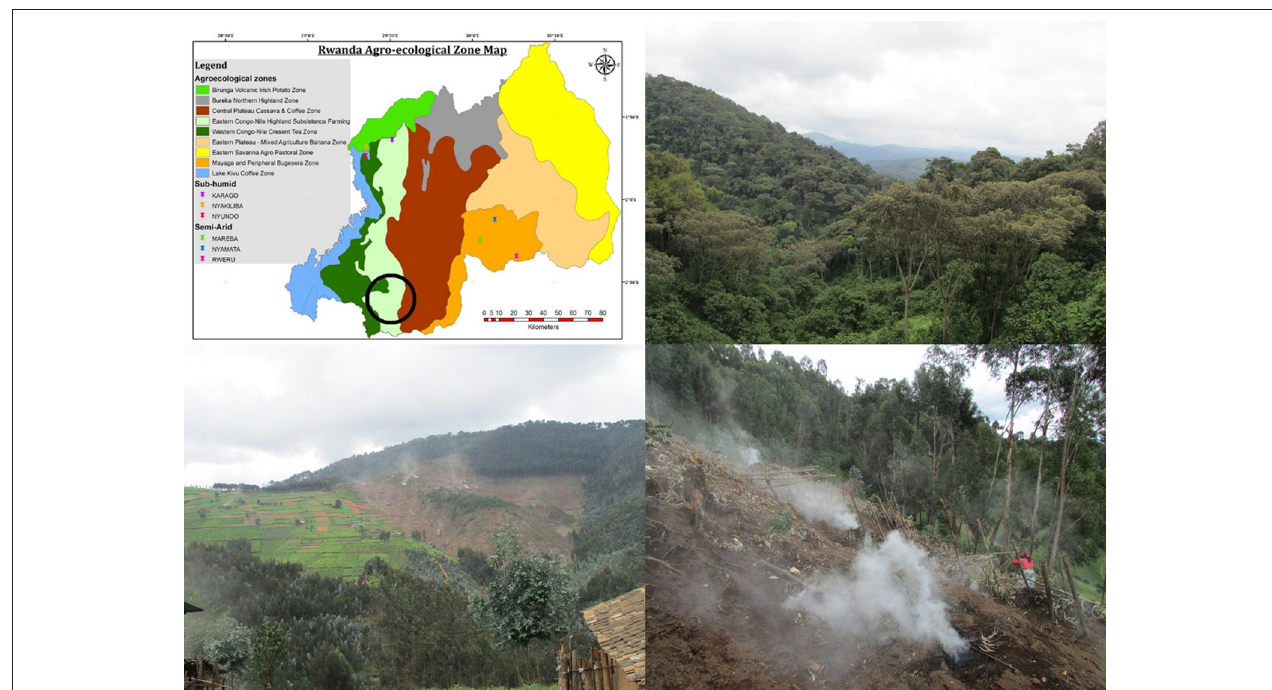
FIGURE 3 | Rwandese site illustration. Nyungwe Forest is the largest block of montane forest in East and Central Africa, home to over 1,000 species, including rare primates, such as chimpanzees, the L’Hoests monkey and Angola Colobus. Nyungwe is also an important water catchment for Rwanda. Western Rwanda is one of the most densely populated regions of the country and at the same time one of the major suppliers of charcoal made from planted Eucalyptus. By ameliorating sloping landscapes and utilizing marginal plots, charcoal production has become an integral part of sustainable agricultural intensification, while creating an income source for farmers, as well as employment opportunities for specialized